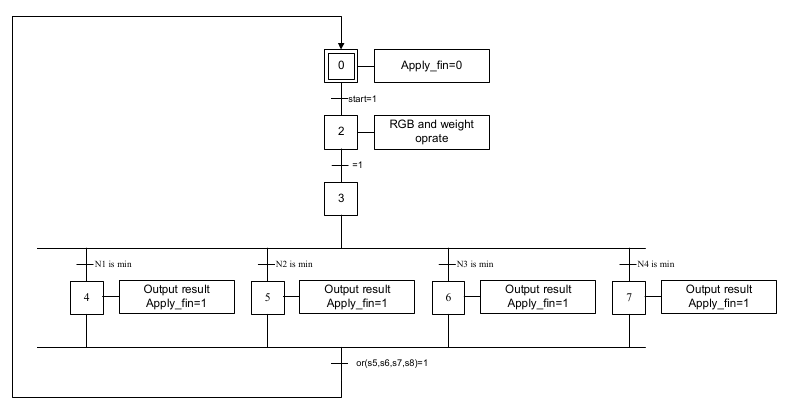
Figure 10. Discrete-event model of the SOM color classification module.